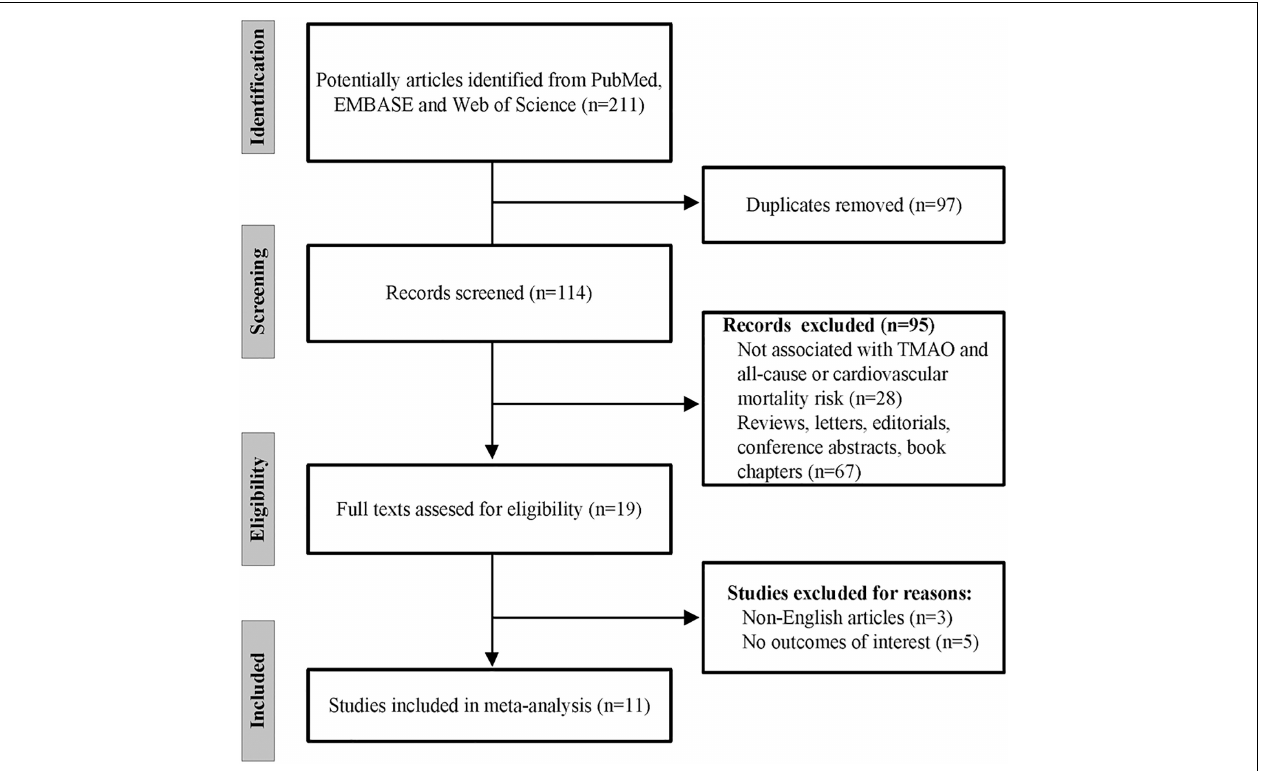
FIGURE 1 | The flow chart of the study selection